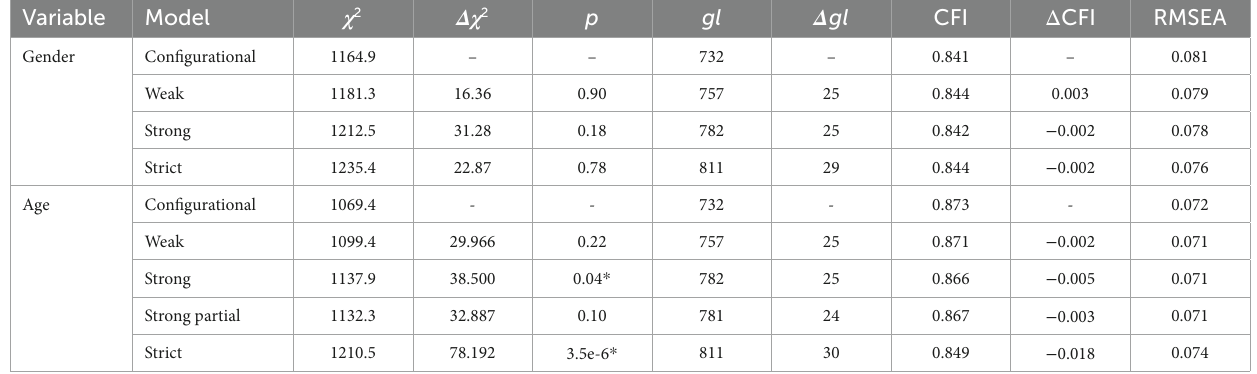
TABLE 5 Analysis of factorial invariance of the EA-COOPTEC v0.1 as a function of gender and age.